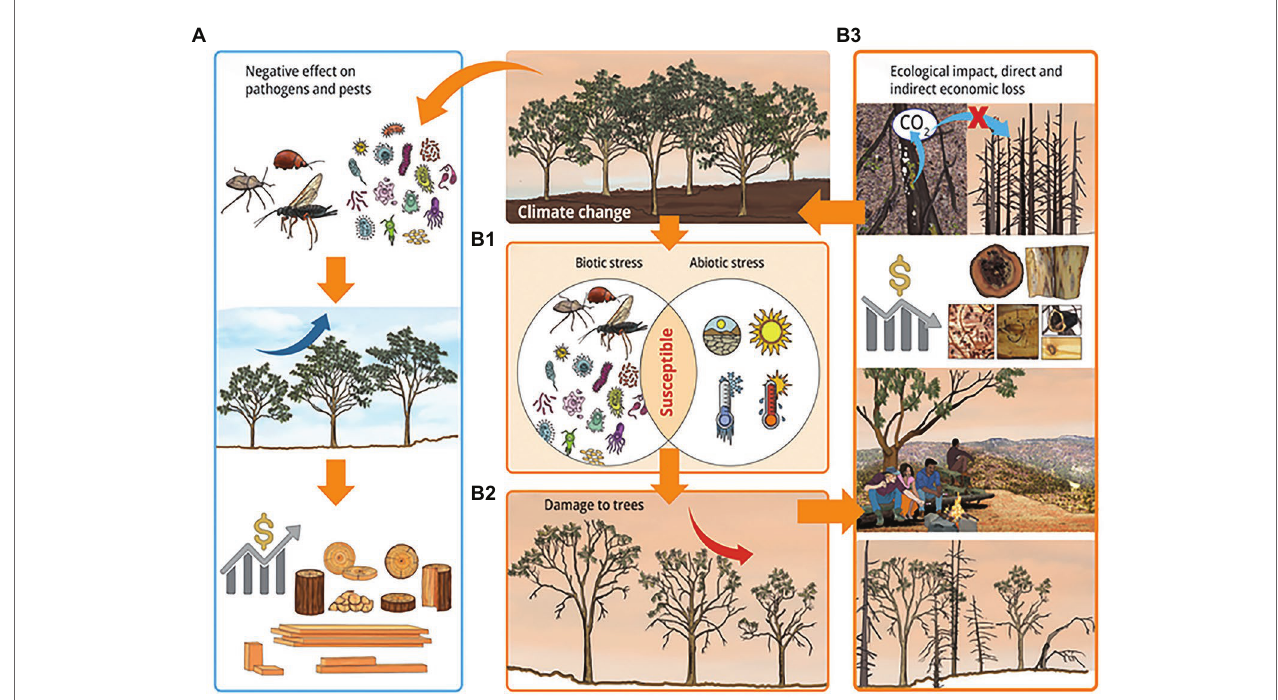
FIGURE 5 | A scheme showing the impact of combined biotic and abiotic stresses in forestry under the influence of climate change. Climate change may reduce damage from diseases and pests by negatively affecting pathogens and insect pests, increase tree growth, and result in beneficial economic and ecological impacts (A) . Climate change, along with increased global distribution of pathogens and pests due to globalization, may increase disease and pest outbreaks as well as the intensity and frequency of abiotic stresses. This increases the susceptibly of tress under combined biotic and abiotic stresses (B1) , and result in increased damage to trees, which includes decline in tree growth, increase in tree mortality, defoliation, and crown die-back (B2) . These damages negatively affect the ecosystem services of trees resulting in harmful economic and ecological impacts (B3) . The negative effect on the ecosystem services of forests include loss of potential carbon sinks and increased emission of biogenic volatile organic compounds, reduction in the quality and productivity of forest products, negative impact on human health and well-being, and loss of micro and macro faunal- and floral-diversities, which may in turn cause loss of indirect services from the forest. Yellow arrows indicate cause and effect relationships, and deep blue and red arrows indicate increase and decrease in tree growth,